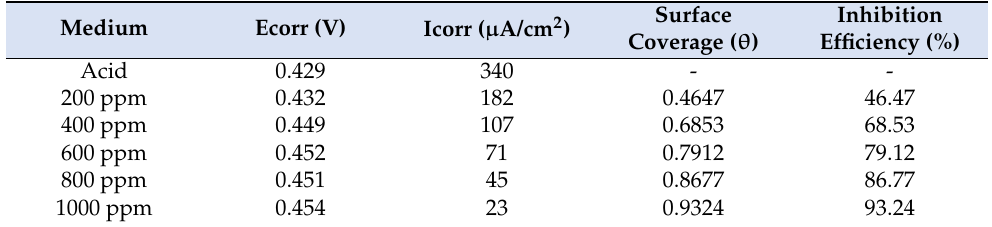
Table 2. Table showing the anodic slope, cathodic slope, and inhibition efficiency for 3 h immersed sample.